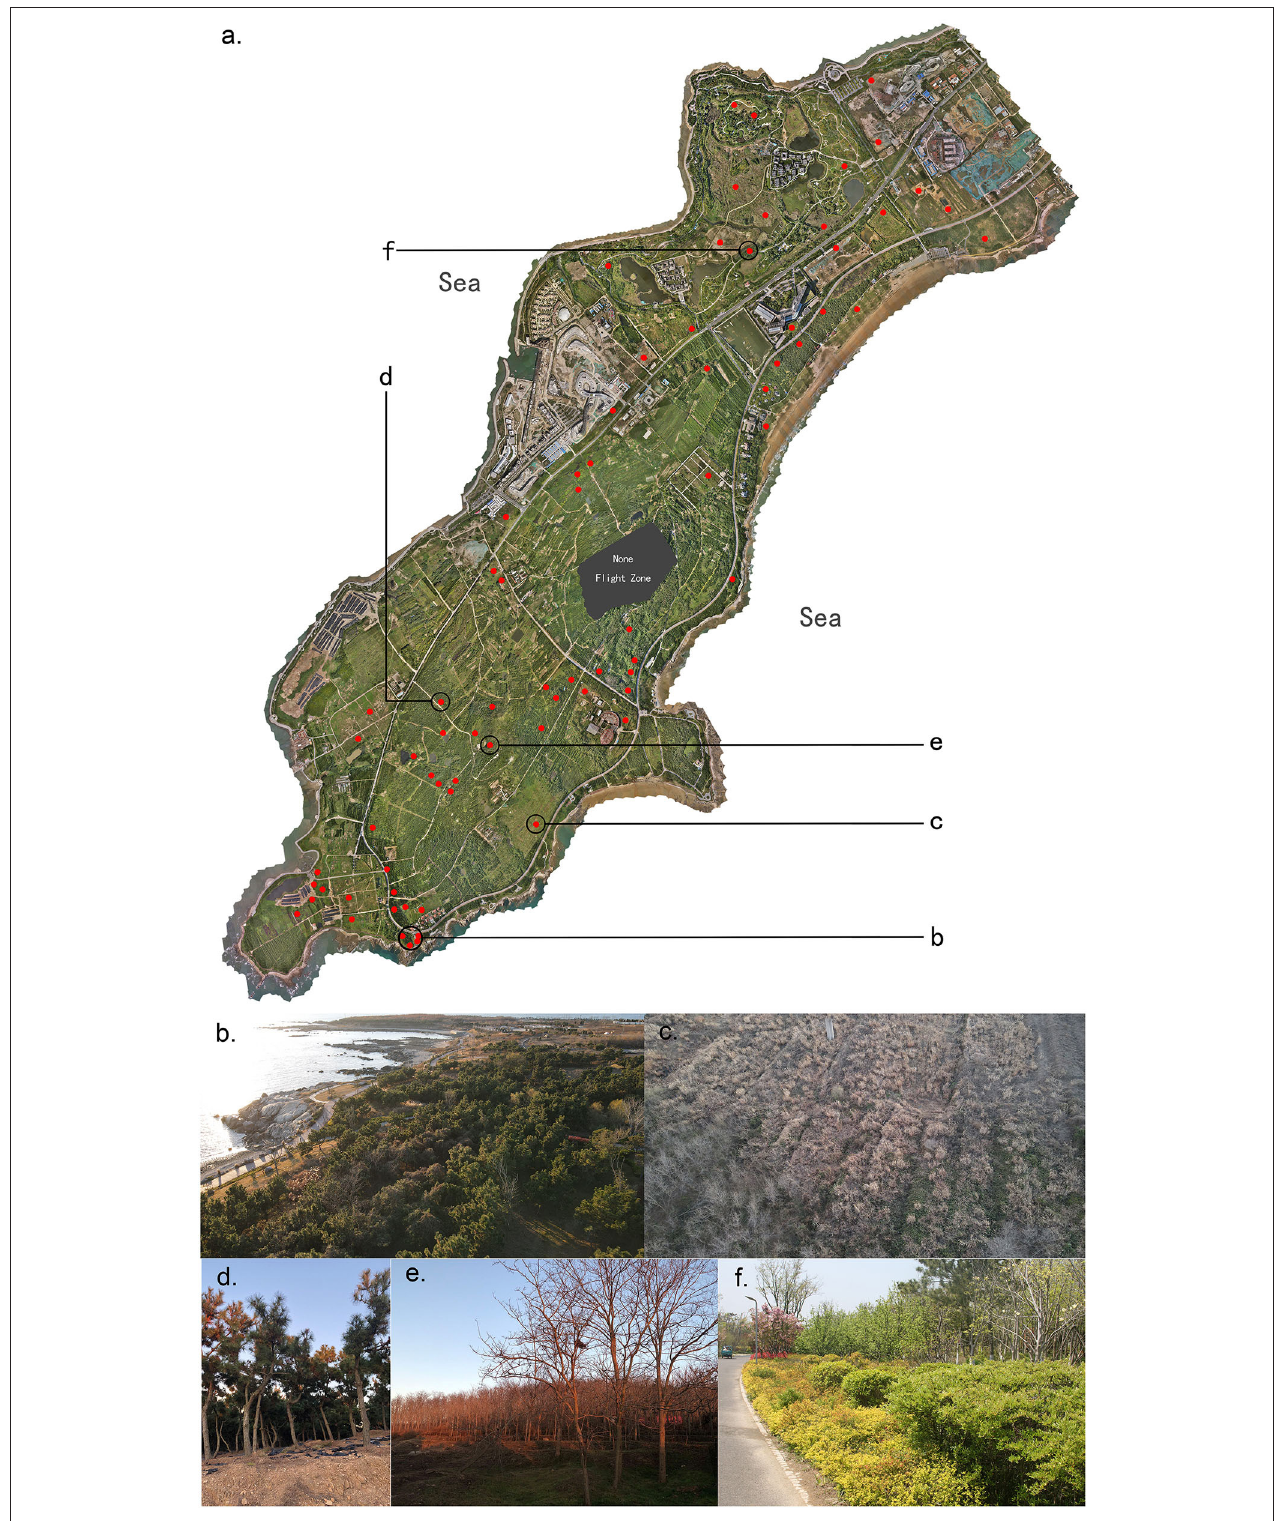
FIGURE 5 | Locations of field investigation (a) and the images of vegetation (b–f) .